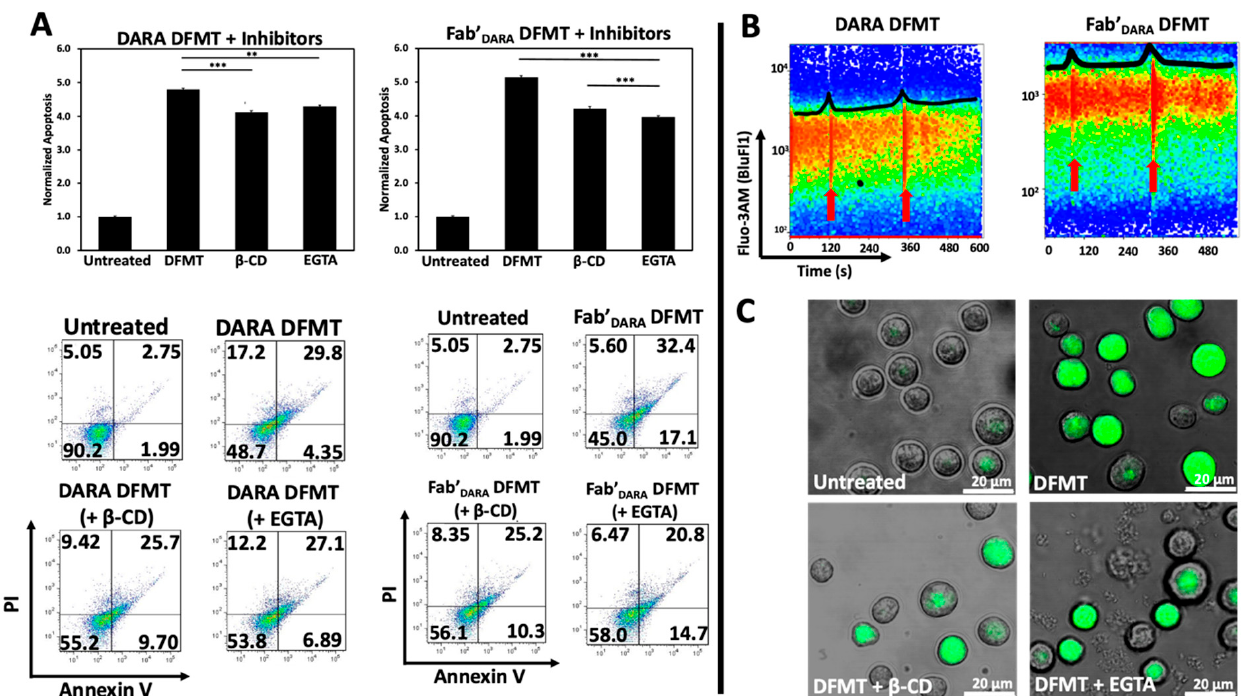
Figure 3. ( A ) Investigation of Raji cell apoptosis induced by DFMT with or without pretreatment with 0.02 wt% β‐ CD or 1 mM EGTA. ( B ) Flow cytometry time lapse fluorescence of calcium chelator Fluo-3AM after addition of nanoconjugates in DARA-based DFMT (DARA-MORF1 + HSA-(MORF2) 10 (left panel) and Fab’ DARA -based DFMT (Fab’ DARA -MORF1 + HSA-(MORF2) 10 ) (right panel). Red arrows indicate time of nanoconjugate addition to cell sample. ( C ) Confocal microscopy images of β -CD or EGTA treated Daudi cells compared to normal cells undergoing Fab’ DARA -based DFMT. *** p < 0.001, ** p < 0.01, n.s. nonsignificant, by One-Way ANOVA and Tukey test.